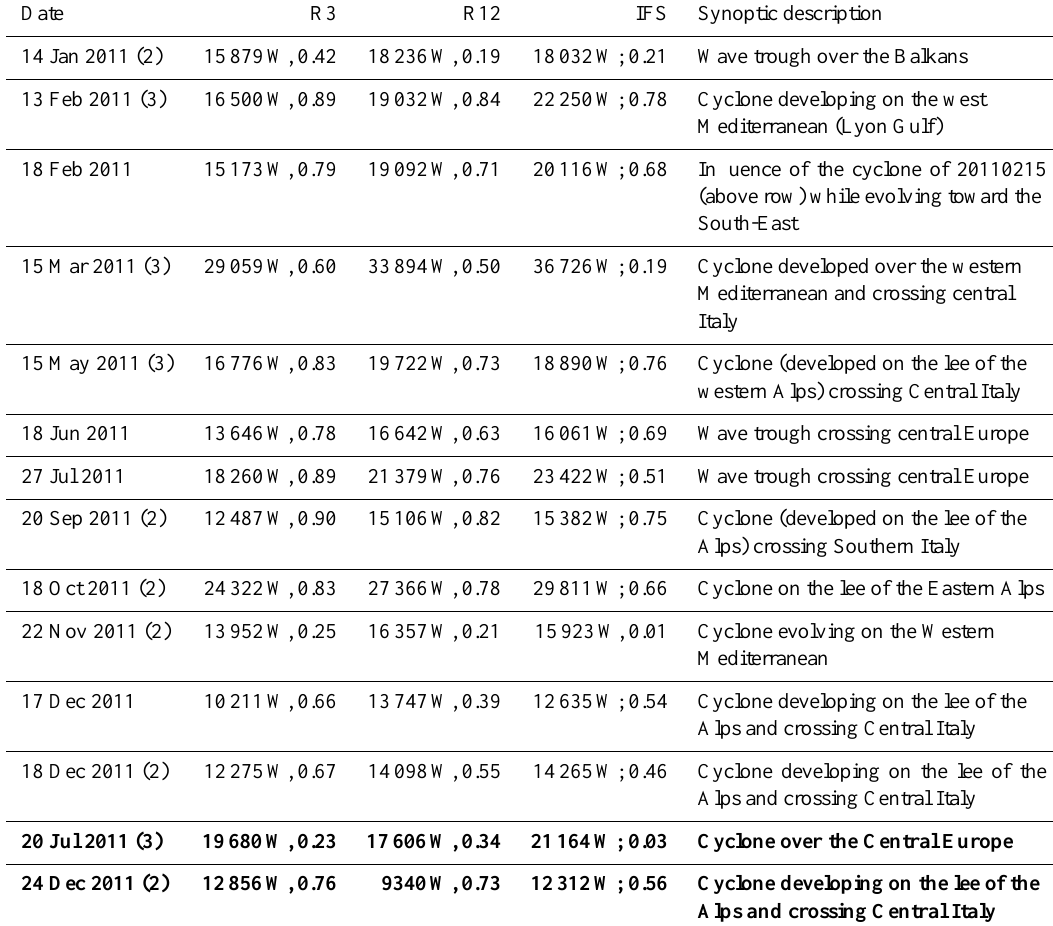
Table 2. Selected events for which the performance of R3 is better than R12 (plain text). A short synoptic description of the events is shows in the last column. Each cell for R3, R12 and IFS shows the value of the RMSE ([W], first value) and of the coefficient of determination ( r 2 , second value). In bold two cases when R12 is better than R3 are shown. The number in parenthesis in the first column shows the consecutive days of better/worse R3 performance compared to R12. For cases lasting more than one day, statistics are shown for the first day of the